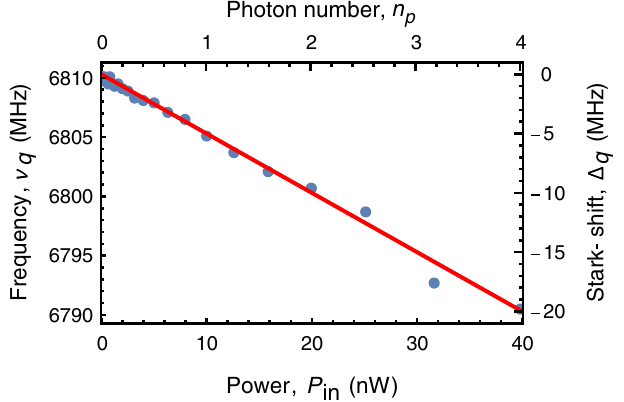
FIG. 8. Stark-shifted frequency ν of the detection qubit (blue q dots) as a function of the input power P at the generator (bottom in axis) and the inferred photon number n in the cavity (top axis). p FIG. 9. Histograms of the integrated quadrature amplitude q of The red curve is a linear fit to the the preselection measurement performed to reject initially excited qubit states. The solid line is a fit to a Gaussian. The dashed gray line indicates the selected threshold. Note that 6% of measure- ment traces above the threshold are discarded.